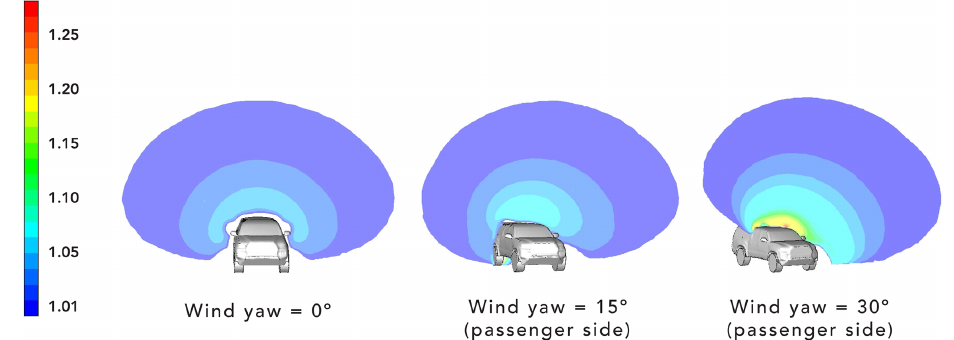
Figure 4. Velocity contours of the lateral plane of the truck along the roof racks for yaw angles of 0, 15, and 30 ◦ . Yellow regions indicate that the wind is accelerated by 18%.